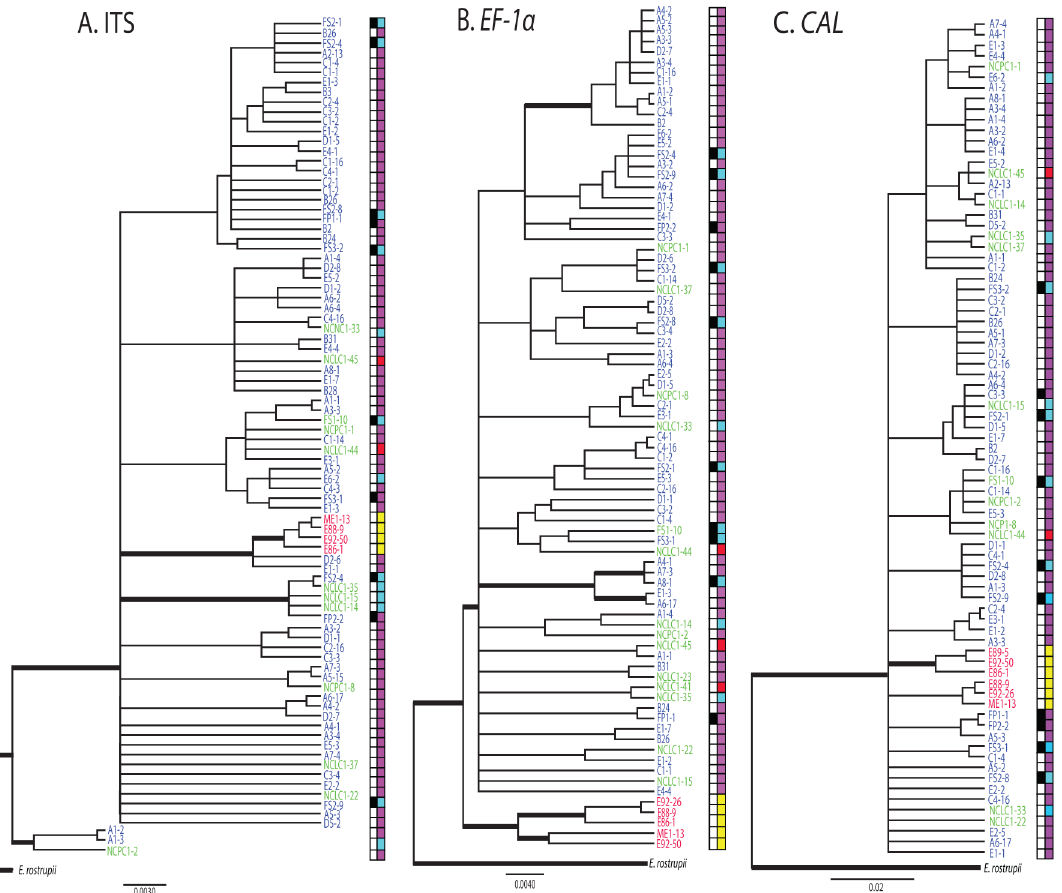
Fig 1. Bayesian inferred phylogenies for isolates of Exobasidium maculosum for the loci A. ITS, B. EF-1 α , C. CAL . Phylogenies were rooted with E . rostrupii . Bold nodes indicate bootstrap support values obtained by maximum likelihood and Bayesian posterior probabilities greater than 70 and 0.90, respectively. Isolate names are colored by geographic location: blue = Georgia; green = North Carolina; red = northeastern North America. The first column of boxes to the right of each phylogeny indicates isolates that were collected from leaf (white) or fruit (black) plant tissues. The second column indicates the host from which isolates were collected: violet = rabbiteye blueberry ( Vaccinium virgatum ); blue = southern highbush blueberry ( Vaccinium corymbosum hybrid); red = highbush blueberry ( V . corymbosum ); yellow = lowbush blueberry ( V . angustifolium ). Isolates of E . rostrupii were collected from leaf spots on cranberry ( V . macrocarpon